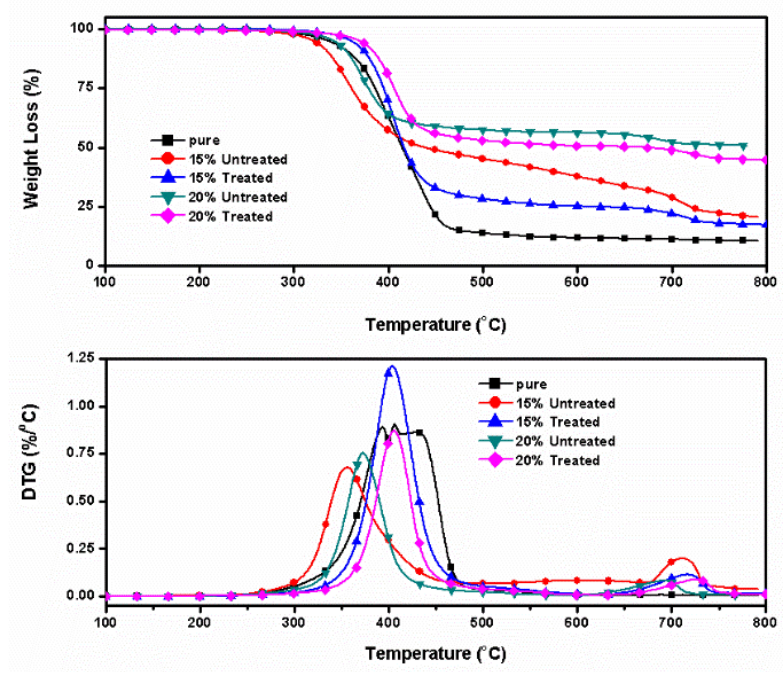
Figure 10. TGA and DTG curves of UES and TES filled epoxy composites on various compositions. The initial degradation temperature (values of T containing epoxy composites were much lower than the neat matrix; however, the 20 wt % UES particles epoxy composites showed a slightly higher values, which may be due to the improved cross links formed between proteins and epoxy as discussed in DMA section. These results are much different than the reported literature due to the alkyl structure attached on the TES particles [18]. The UES particles only increases the char yield values for the composites which were much higher than the neat matrix. However, the TES particles also increase the thermal stability of composites. The TES particles filled epoxy composites also showed the improved initial degradation temperature as the loading of TES particles increased. The DTG peak values for the TES/epoxy composites were moved to higher temperature. Table 7. TGA and DTG data of pure, UES and TES composites investigated under nitrogen atmosphere. Sample